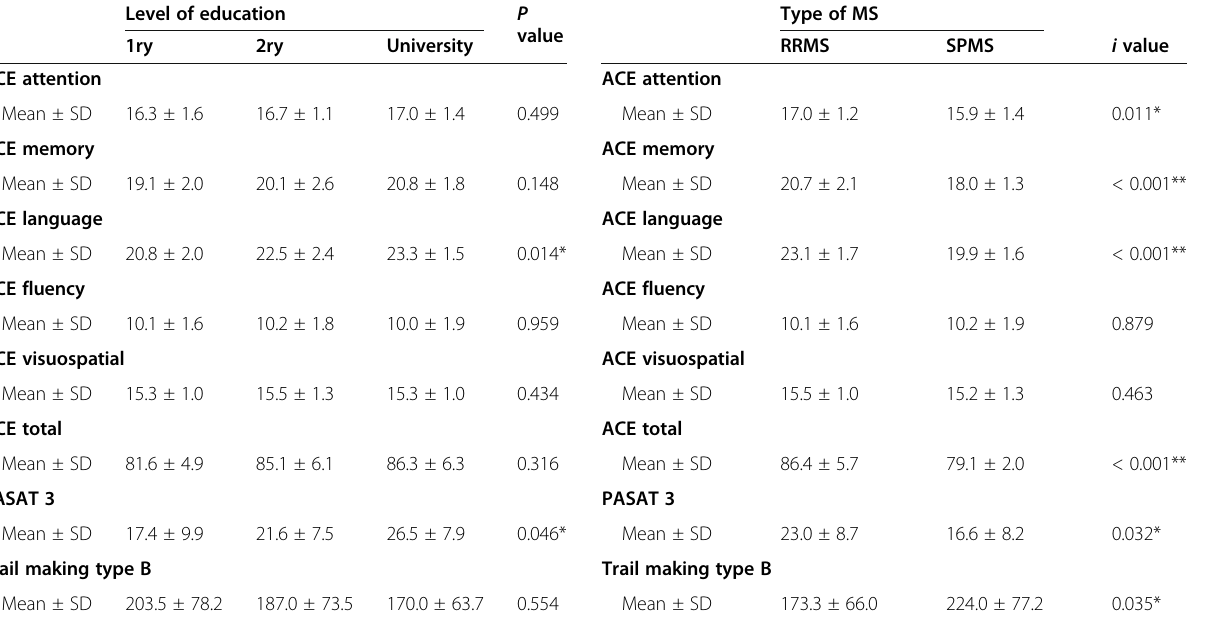
Table 3 Comparison of mean cognitive scale scores between MS patients with different levels of education